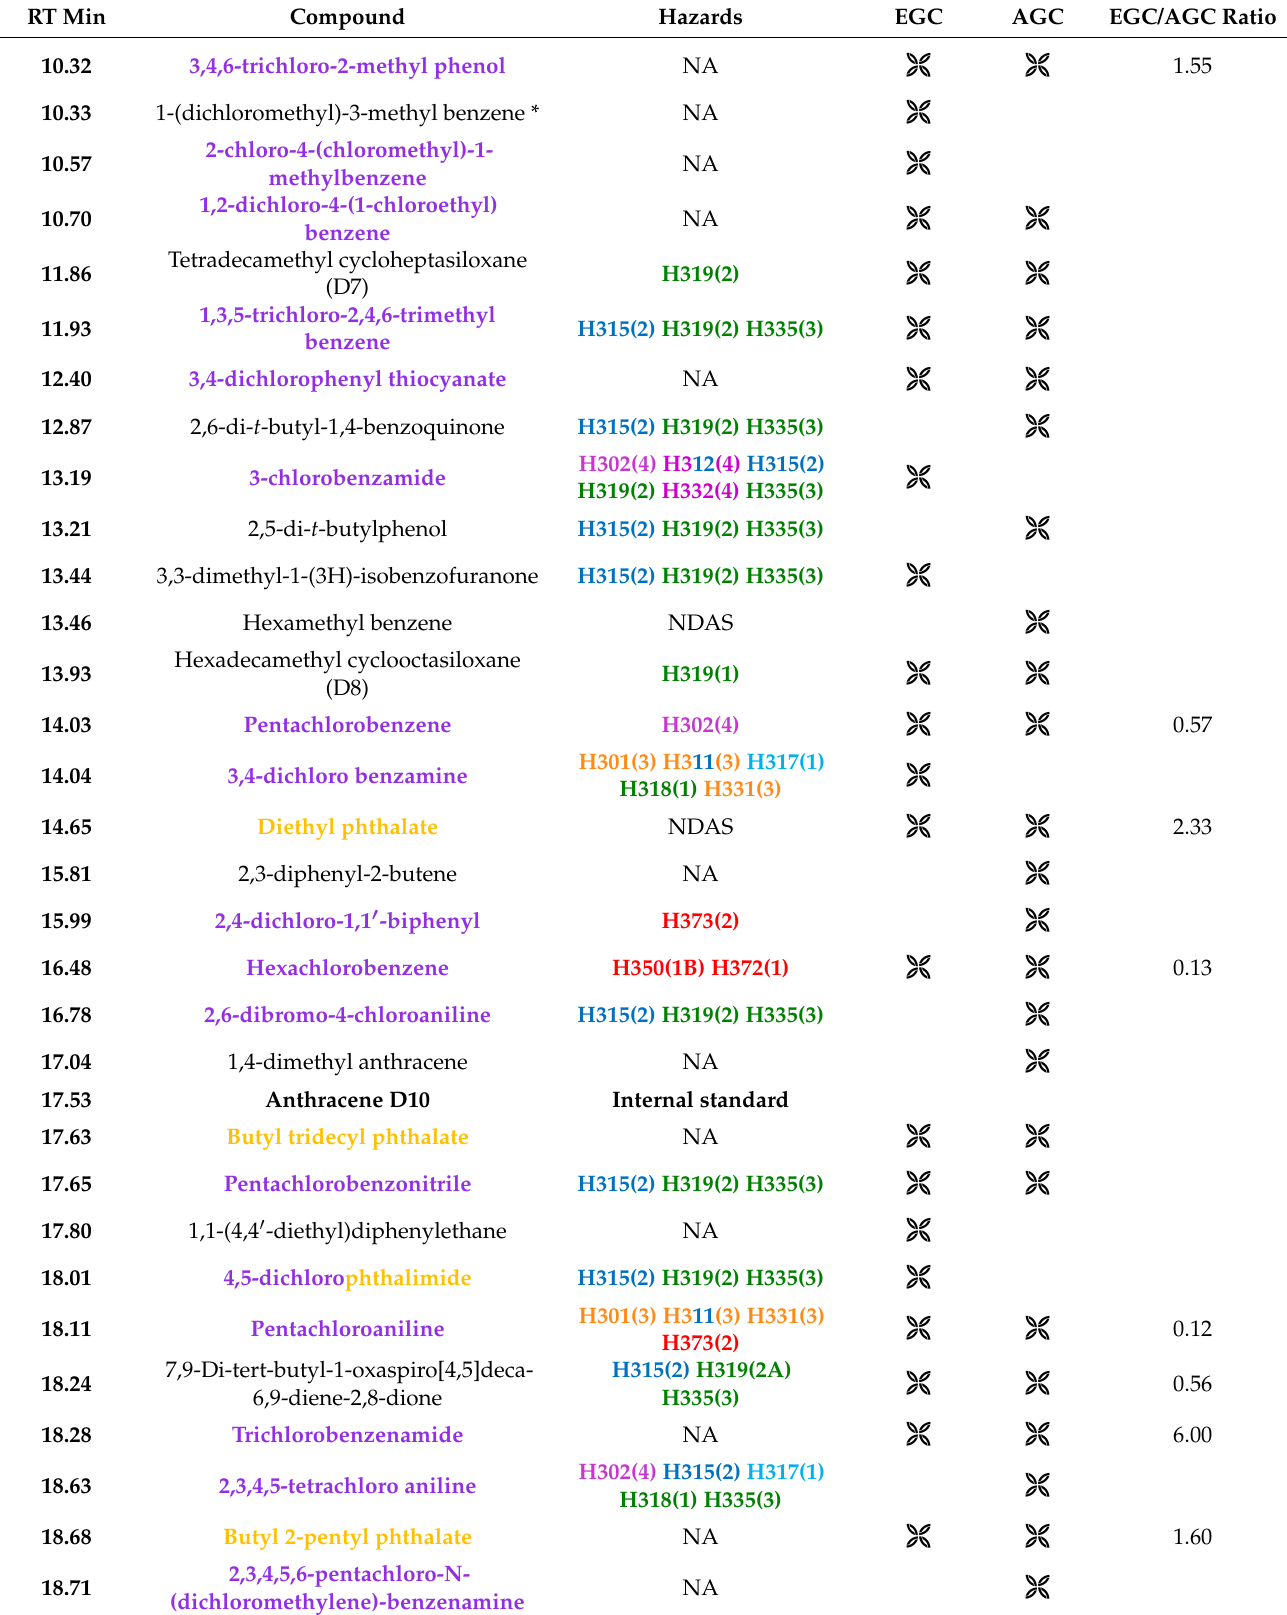
Table 2. Selection of the most hazardous compounds extracted in water, acetone and CCl 2 H 2 , and corresponding hazard codes. Chlorinated compounds are reported in violet , phthalates in orange and peculiar compounds of AGC in light blue . The colours assigned to different hazards indicate: Red = lethality , Orange = Toxicity , Pink = Harmfulness , Red = lethality , Bluish = skin related issues , Green = irritation, damage, drowsiness .